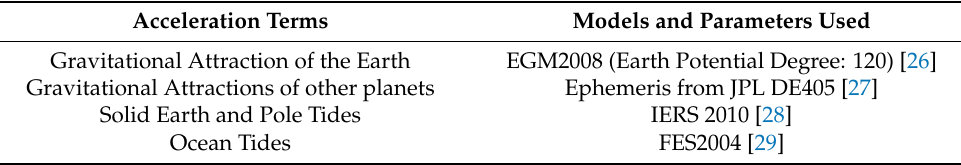
Table 1. Dynamic models used for orbit numerical integration. Acceleration Terms Models and Parameters Used Gravitational Attraction of the Earth EGM2008 (Earth Potential Degree: 120) [26] Gravitational Attractions of other planets Ephemeris from JPL DE405 [27] Solid Earth and Pole Tides Ocean